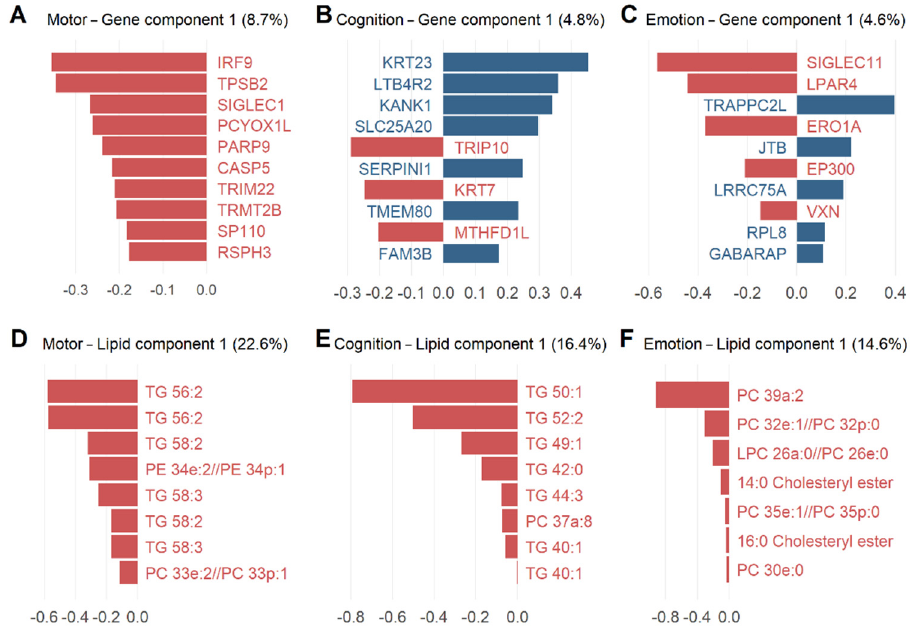
Figure 3. Loading plots indicating the importance of each variable to define the principal component. The weights of the top 10 genes ( A – C ) and lipids ( D – F ) were represented are a positive (in blue) and negative (in red) correlation for the motor, cognitive and emotion models.